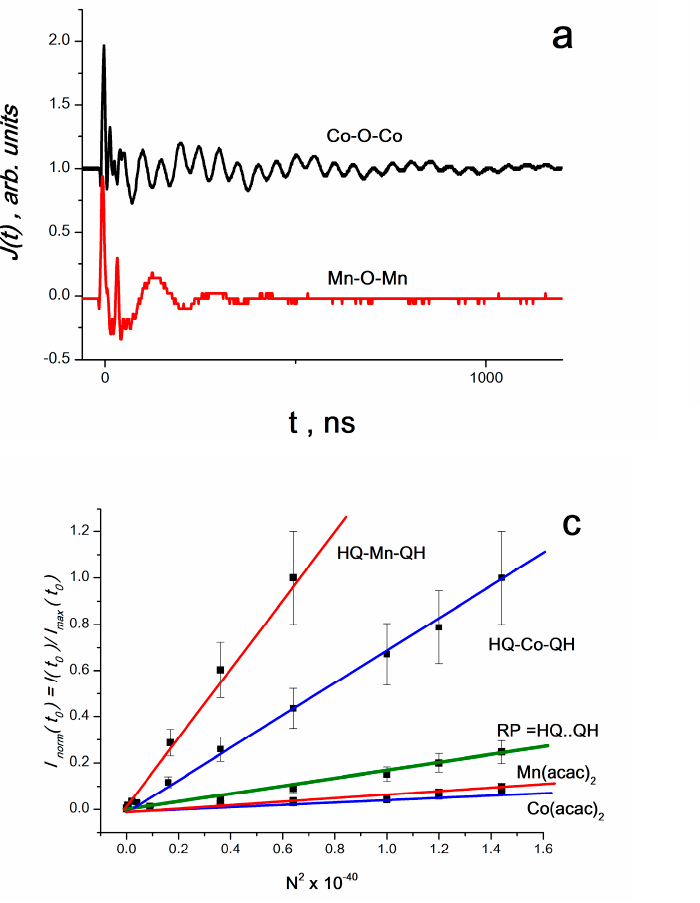
Figure 4. ( a ) normalized time sweep of the electrical signal; ( b ) normalized time sweep of the gen- erated power at the load resistance; ( c ) normalized dependence of the ratio I EMR,norm = I EMR ( t 0 )/ I EMR,max ( t 0 ) on N 2 ( N MAX = 1.2·10 20 —the maximum number of complexes in 1 cm 3 ) on the